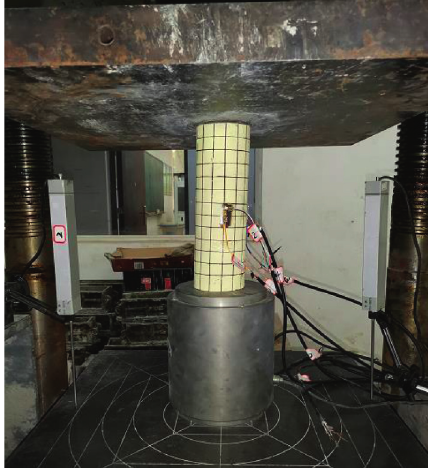
Figure 2: Test setup.